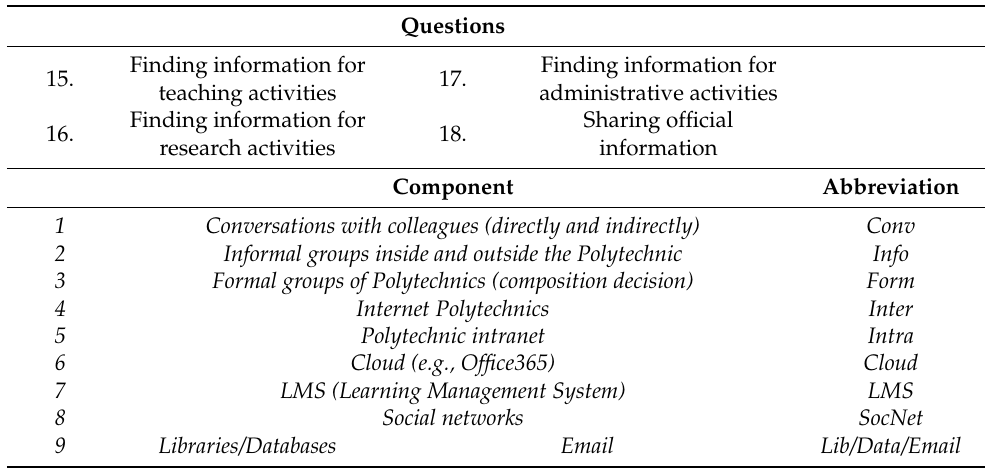
Table 1. Questions and components in the